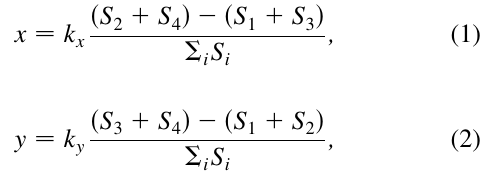
BPMs.*Electronic address: gh77@cornell.edu Corresponding